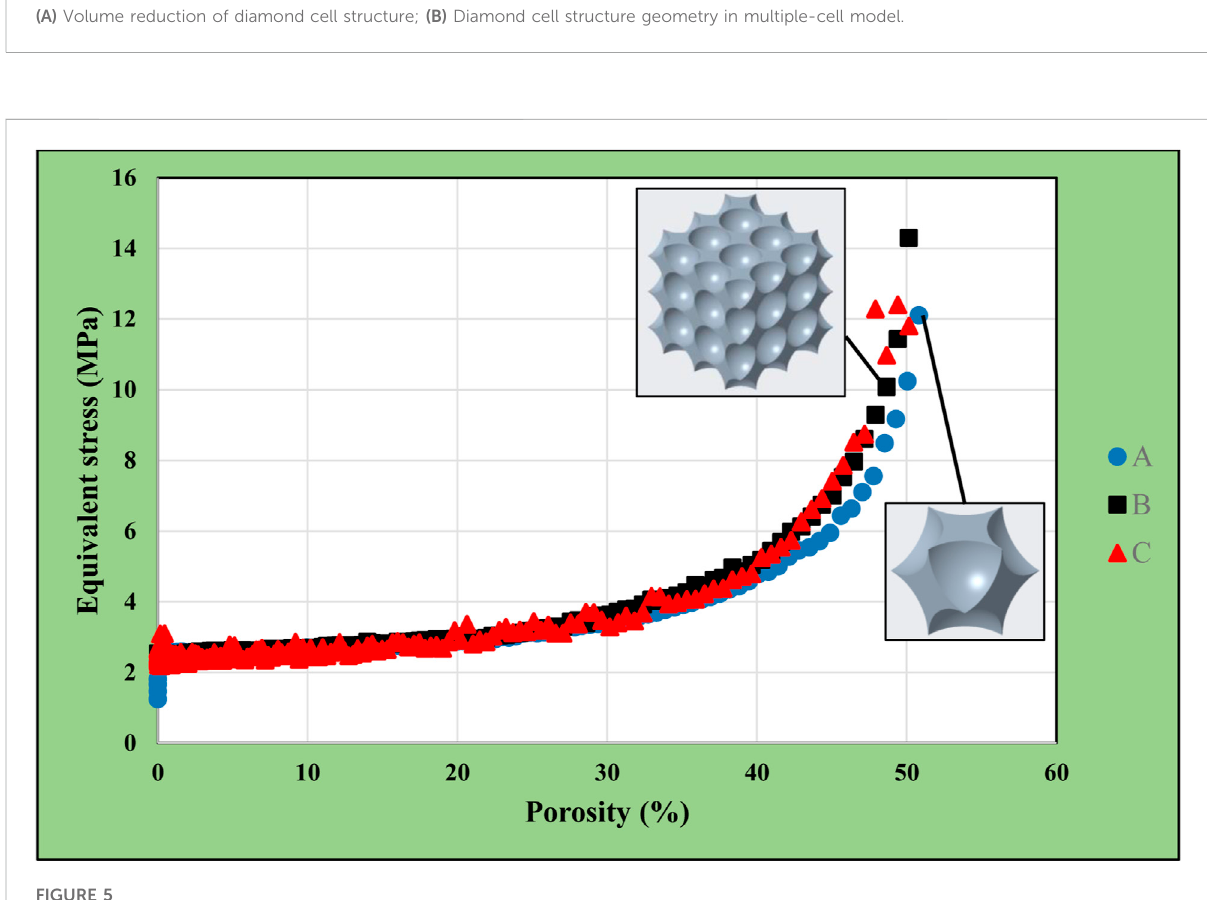
FIGURE 5 Equivalent stress as a function of porosity in single-cell and multi-cell structures of simple cubic